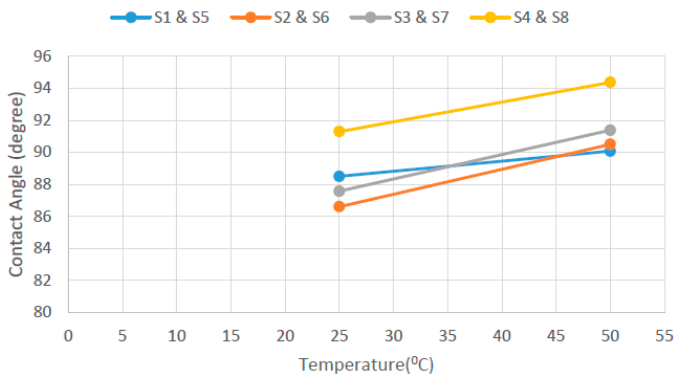
Figure 6. Contact angle variation in eight samples with increase in temperature for brine B2.